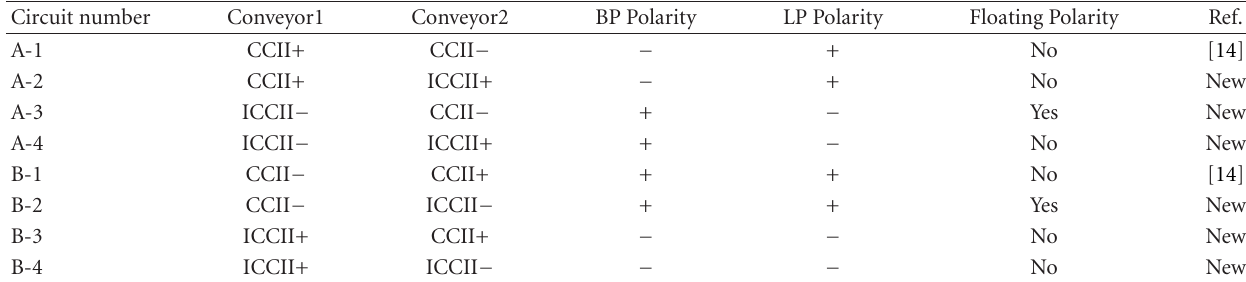
Table 1: Types of conveyors used in the generalized filter of Figure